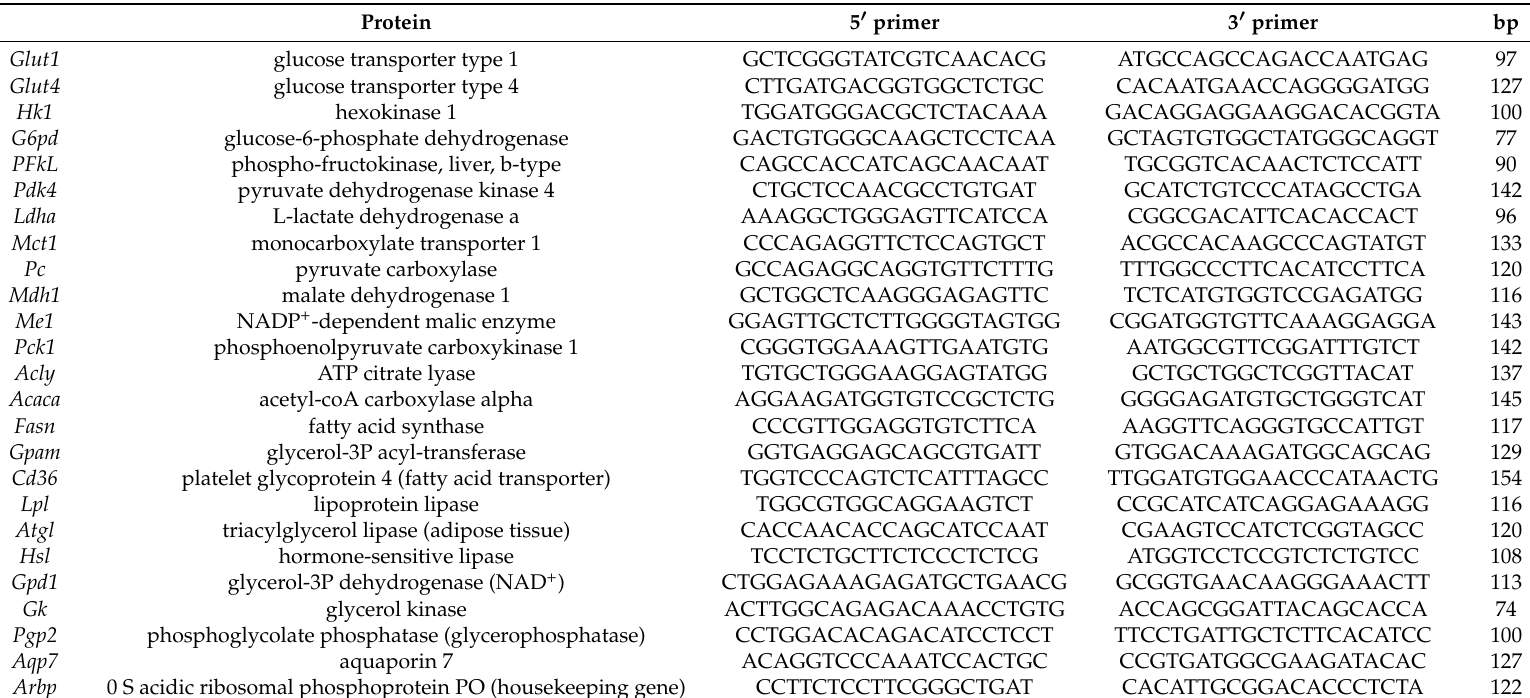
Table 1. Table 1 . Primers used for the analysis of gene